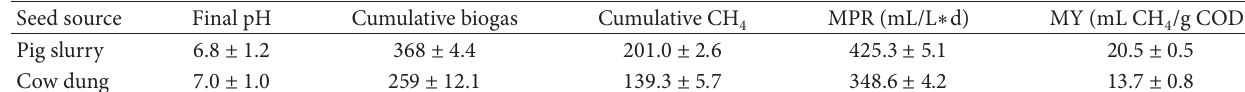
fermentor effluent. 2